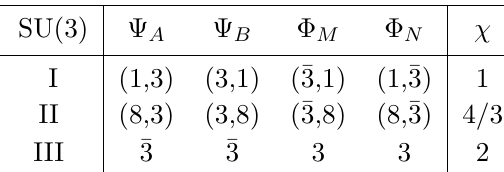
Table 7 . Table of SU(3)-factors entering the box induced Wilson coe(cid:14)cients involved in b ! s transitions for crossed diagrams with complex